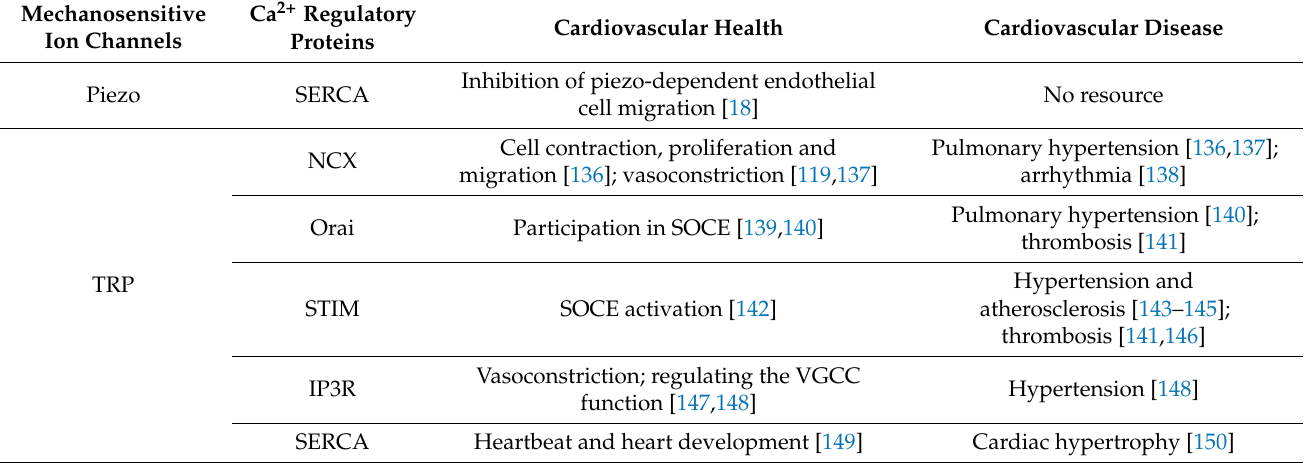
Table 3. Summary of the cross-talk between mechanosensitive ion channels and Ca 2+ regulatory proteins in cardiovascular health and